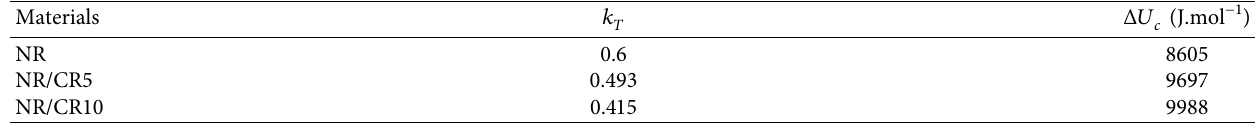
Table 7: Δ U c of NR and NR/CR blends after the complex